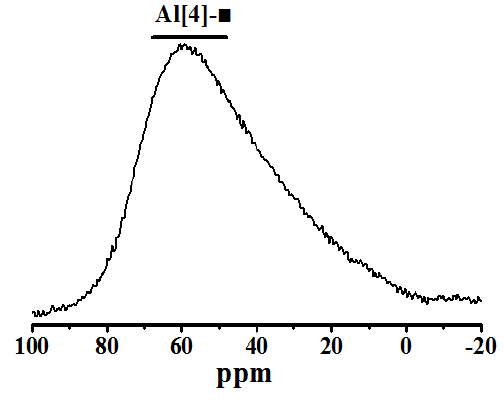
Figure 6. 27 Al NMR spectrum of raw material.